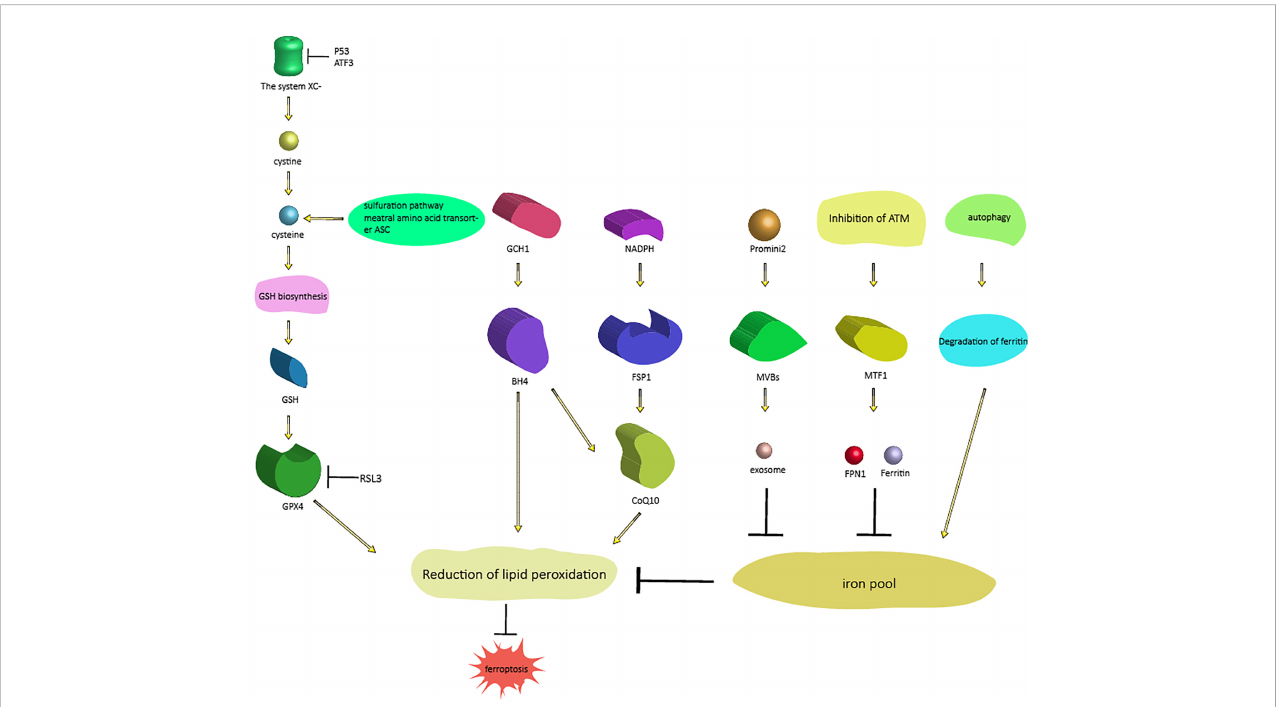
FIGURE 1 Signaling pathways regulating ferroptosis. There are two different processes that regulate ferroptosis. One process includes three pathways that regulate ferroptosis (from right to left) by regulating intracellular iron content: the autophagy pathway, the ferritin-FPN1 pathway [ATM-MTF1-ferritin-FPN1], and the exosome pathway [Prominin2-MVB-exosomes]; the other process regulates another three pathways of ferroptosis (from left to right) by regulating lipid peroxidation: the GSH pathway, BH4 pathway [GCH1-BH4] and CoQ10 pathway [NAD(P)H-FSP1-CoQ10]. As mentioned above, these proteins and genes are also affected by upstream proteins and genes. Abbreviations: MTF1, metal-regulated transcription factor 1; FPN1, ferroportin 1; MVBs, multivesicular bodies; GSH, glutathione; GPX, glutathione peroxidase; GCH1, GTP cyclohydrolase-1; BH4, tetrahydrobiopterin; FSP1, ferroptosis suppressor protein